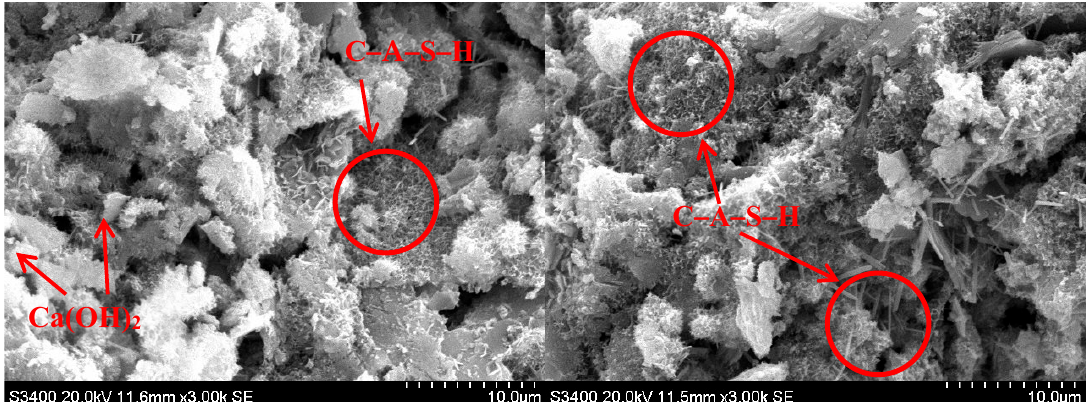
Figure 14. SEM images of B3 specimens that included BOFS with a fineness of 10,000 cm 2 /g.